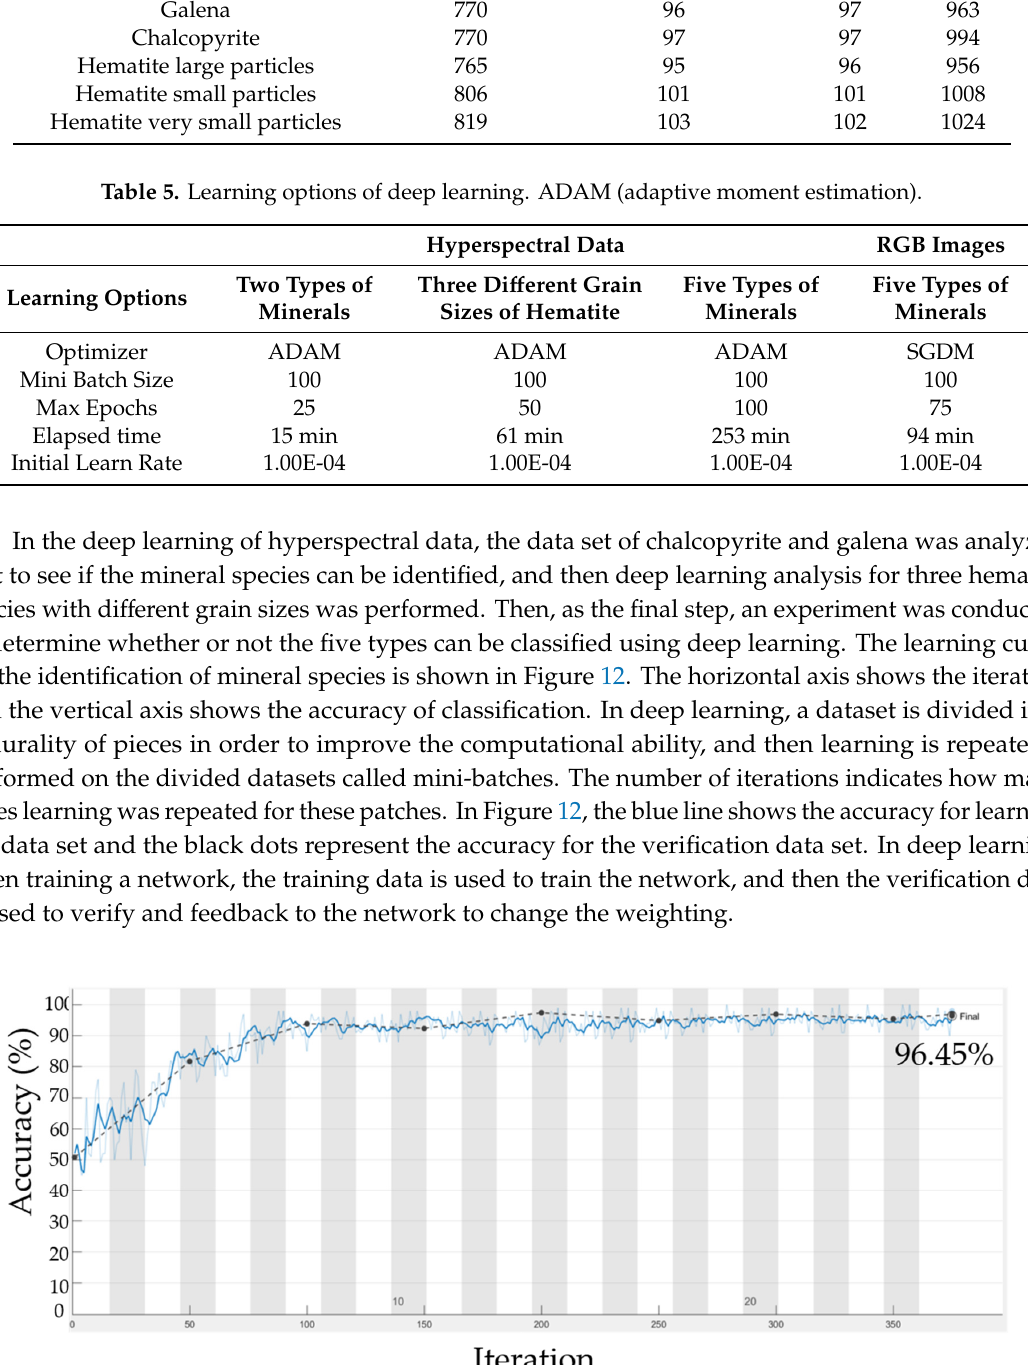
Figure 13. Confusion matrix of the deep learning results for two types of rocks using test data. Next, hyperspectral data was acquired for three types of mineral samples with different grain sizes, and they were similarly classified by deep learning. The learning curve is shown in Figure 14. By analyzing the hyperspectral data of the same mineral with deep learning, it was possible to classify with accuracy as high as 94.31%, similar to the identification of mineral species. Figure 15 shows the confusion matrix of the learning results of the classification of the three different grain sizes of hematite, in which the performance of the classifier was evaluated using test data that was not used for learning. The classification accuracy of the training model for the test data of hematite small particles was 86.1%; however, the overall classification accuracy was 92.3%.